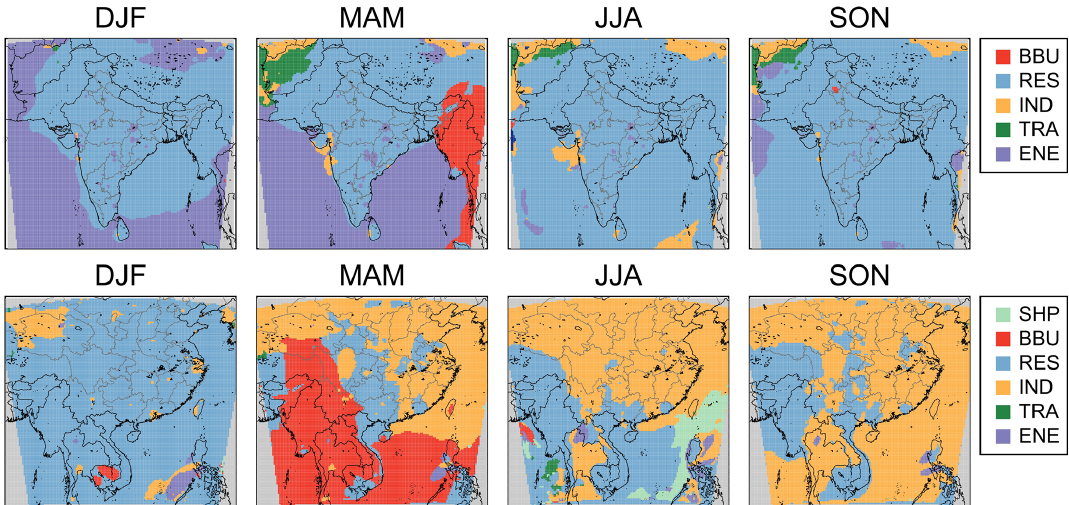
Figure 5. Spatial distribution of the dominant anthropogenic emission sectors for seasonal mean PM 2 . 5 in South Asia (top panel) and East Asia (bottom panel). DJF: December, January, February mean; MAM: March, April, May mean; JJA: June, July, August mean; SON: September, October, November mean. As for Fig. 4, the dominant emission sector is calculated for each model grid cell as the emission sector that gives the largest reduction in simulated seasonal mean surface PM 2 . 5 concentration, i.e. results in the largest absolute difference in µgm − 3 from the control simulation. Regions in grey are outside the model domain. The emission sectors shown are power generation (ENE), industrial non-power (IND), residential energy use (RES), land transport (TRA), open biomass burning (BBU), and shipping (SHP; East Asia